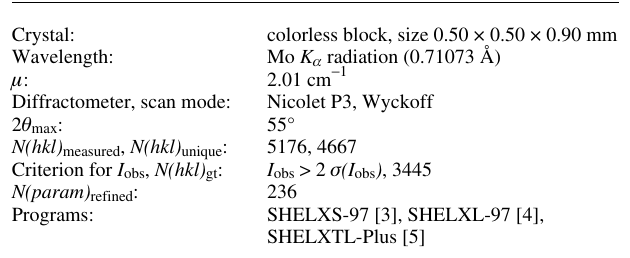
Table 1. Data collection and handling.